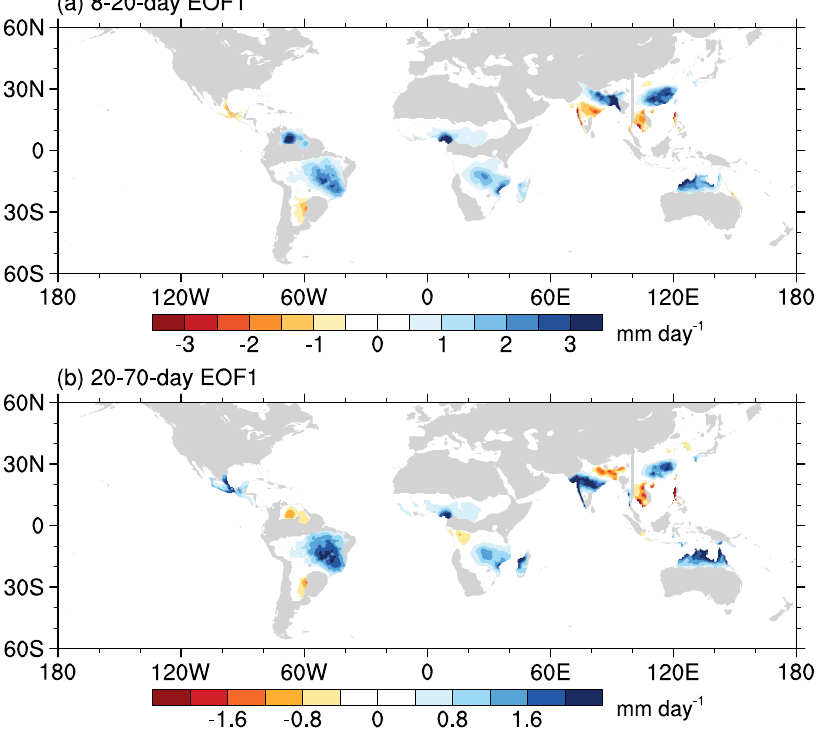
Fig. 3 Dominant ISV modes in individual summer monsoon regions. The spatial patterns of the fi rst EOF modes of summer sub-seasonal precipitation anomalies (shading; mm day − 1 ) for a 8 – 20-day ISV and b 20 – 70-day ISV over each monsoon region during the summers of 1979 – 2018. The EA and SA regions are separated by the gray